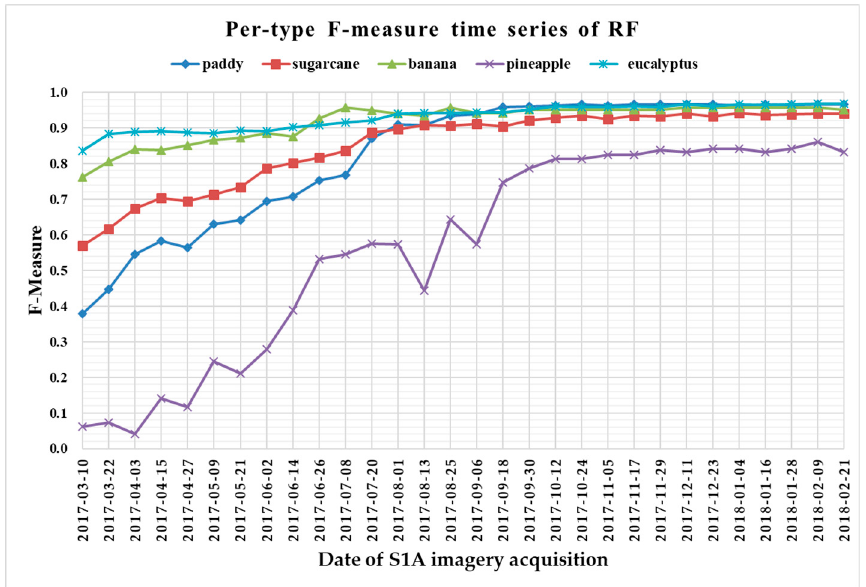
Figure 15. F-measure time series of gated recurrent unit recurrent neural networks.